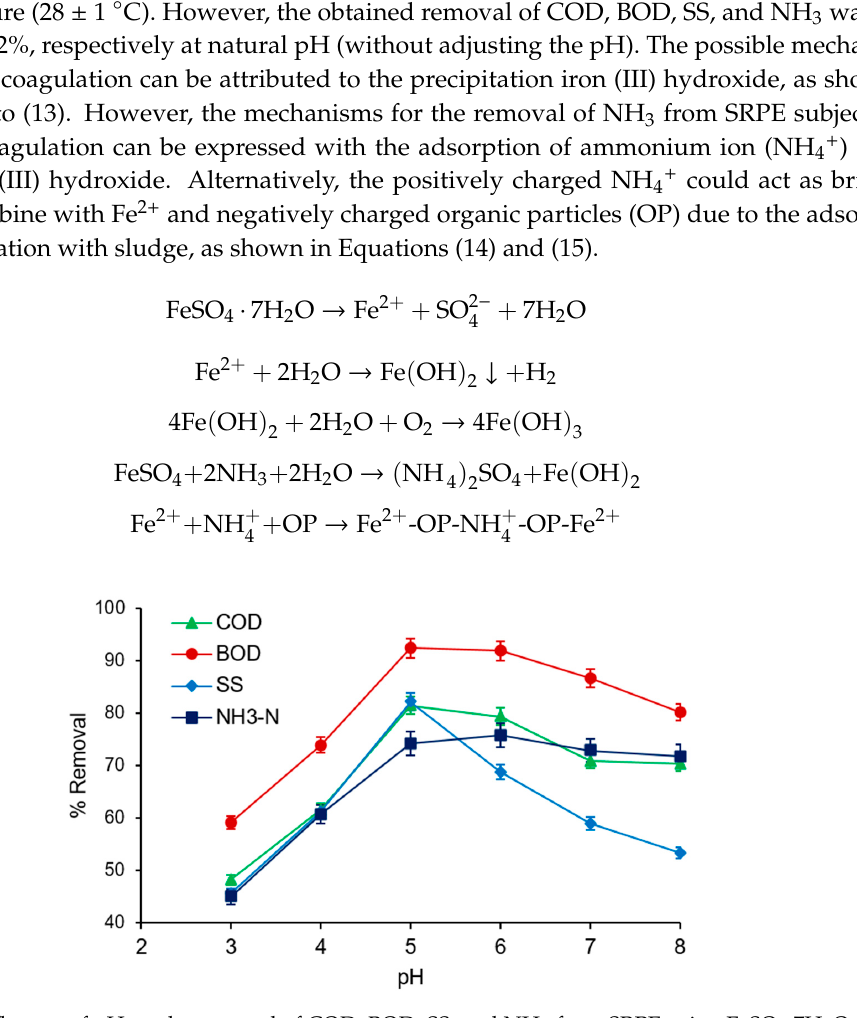
Figure 2. Influence of coagulant doses on the removal of COD, BOD, SS, and NH 3 from SRPE using FeSO 4 ·7H 2 O as a coagulant. pH 5, coagulation time of 60 min, and sedimentation time of 60 min.